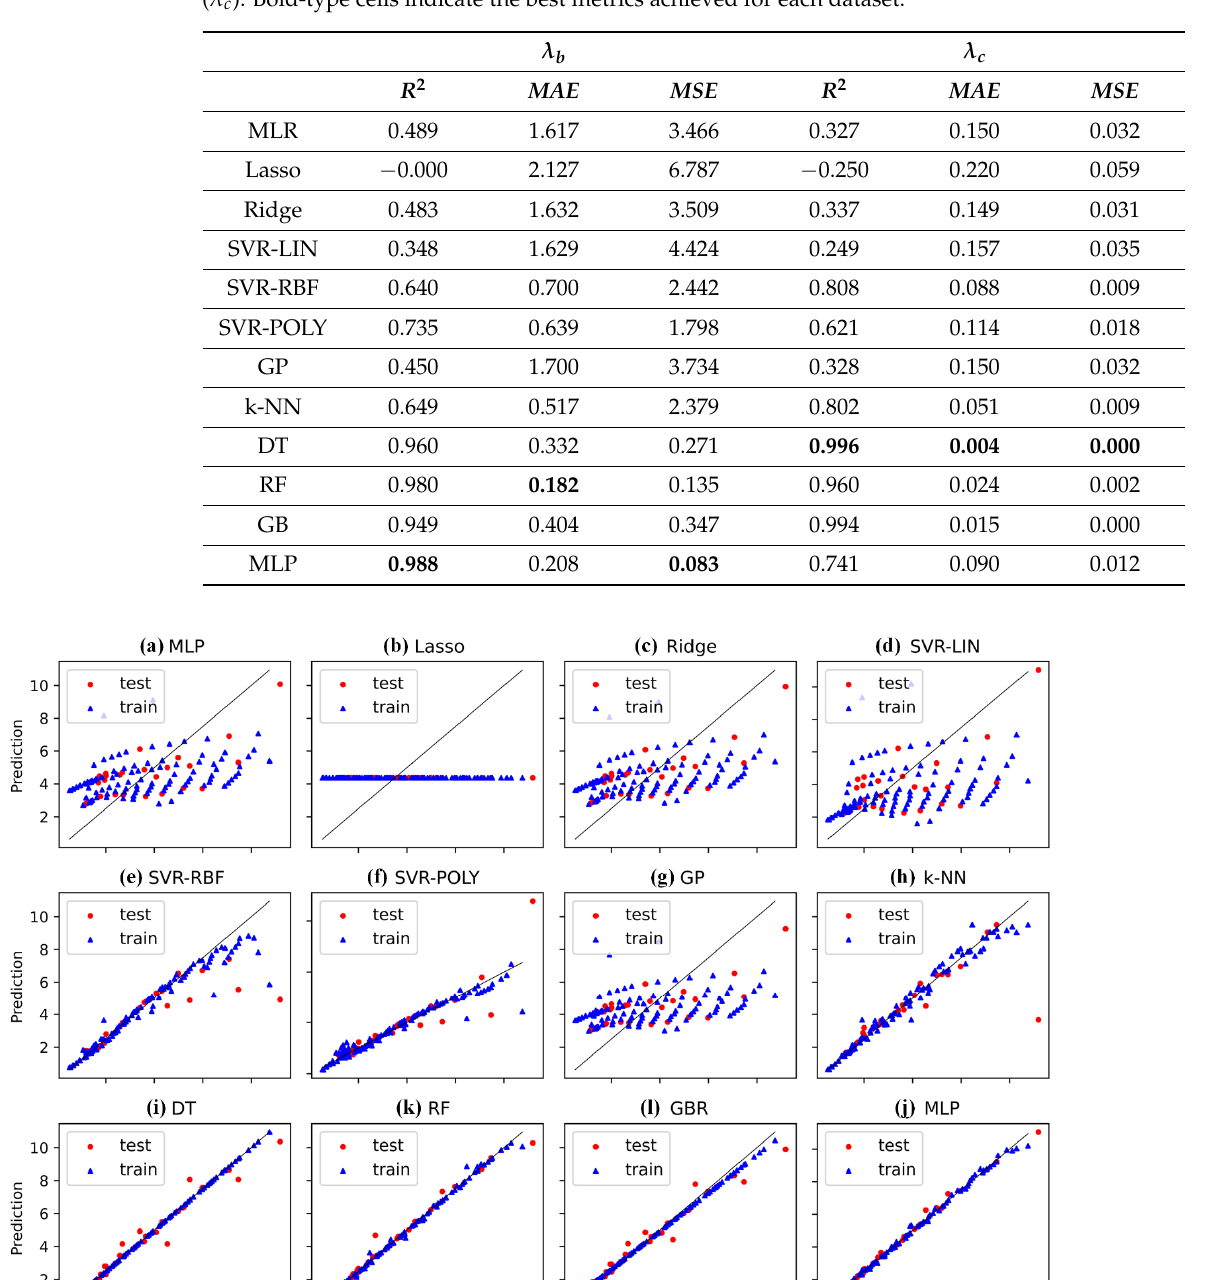
Table 3. Metrics and comparison of 12 ML algorithms for the datasets corresponding to simulation data for LJ bulk fluid thermal conductivity ( λ b ) and LJ liquid thermal conductivity in Poiseuille flow ( λ c ). Bold-type cells indicate the best metrics achieved for each dataset.